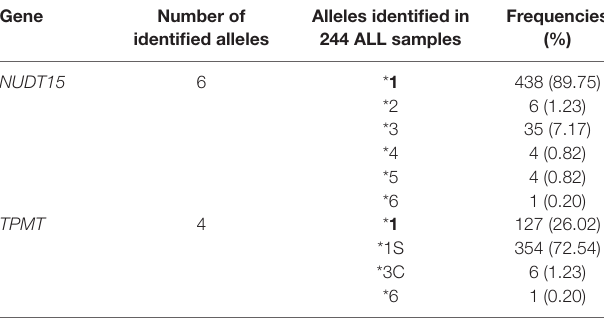
TABLE 2 | Alleles identified in 244 ALL samples with known allele functions.